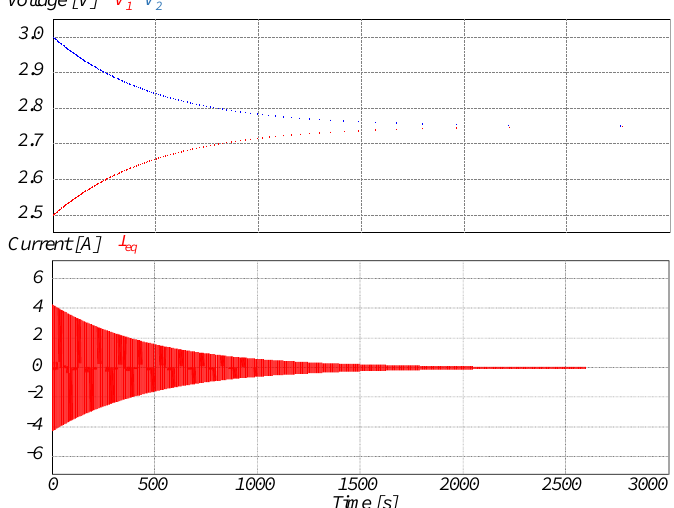
Figure 18. Classic capacitor-based equalizer.